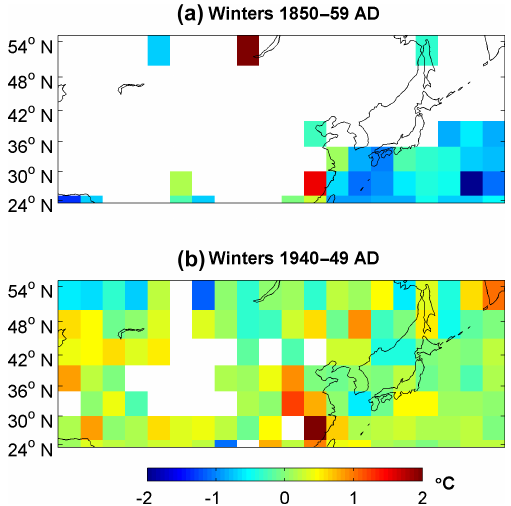
Figure 2. HadCRUT3v instrumental coverage in the PAGES 2K box for Asia during the first (1850–1859 AD) and last (1940– 1949 AD) decade of the period. The values are decadal winter mean temperatures as anomalies with respect to the 1850–1949 AD